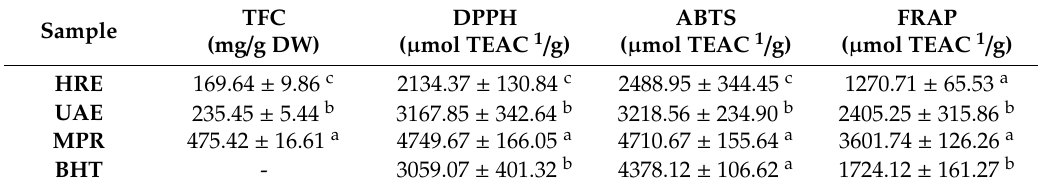
Table 7. TFC and in vitro cell-free antioxidant activity of the di ff erent extracts from N. lotus stamen.